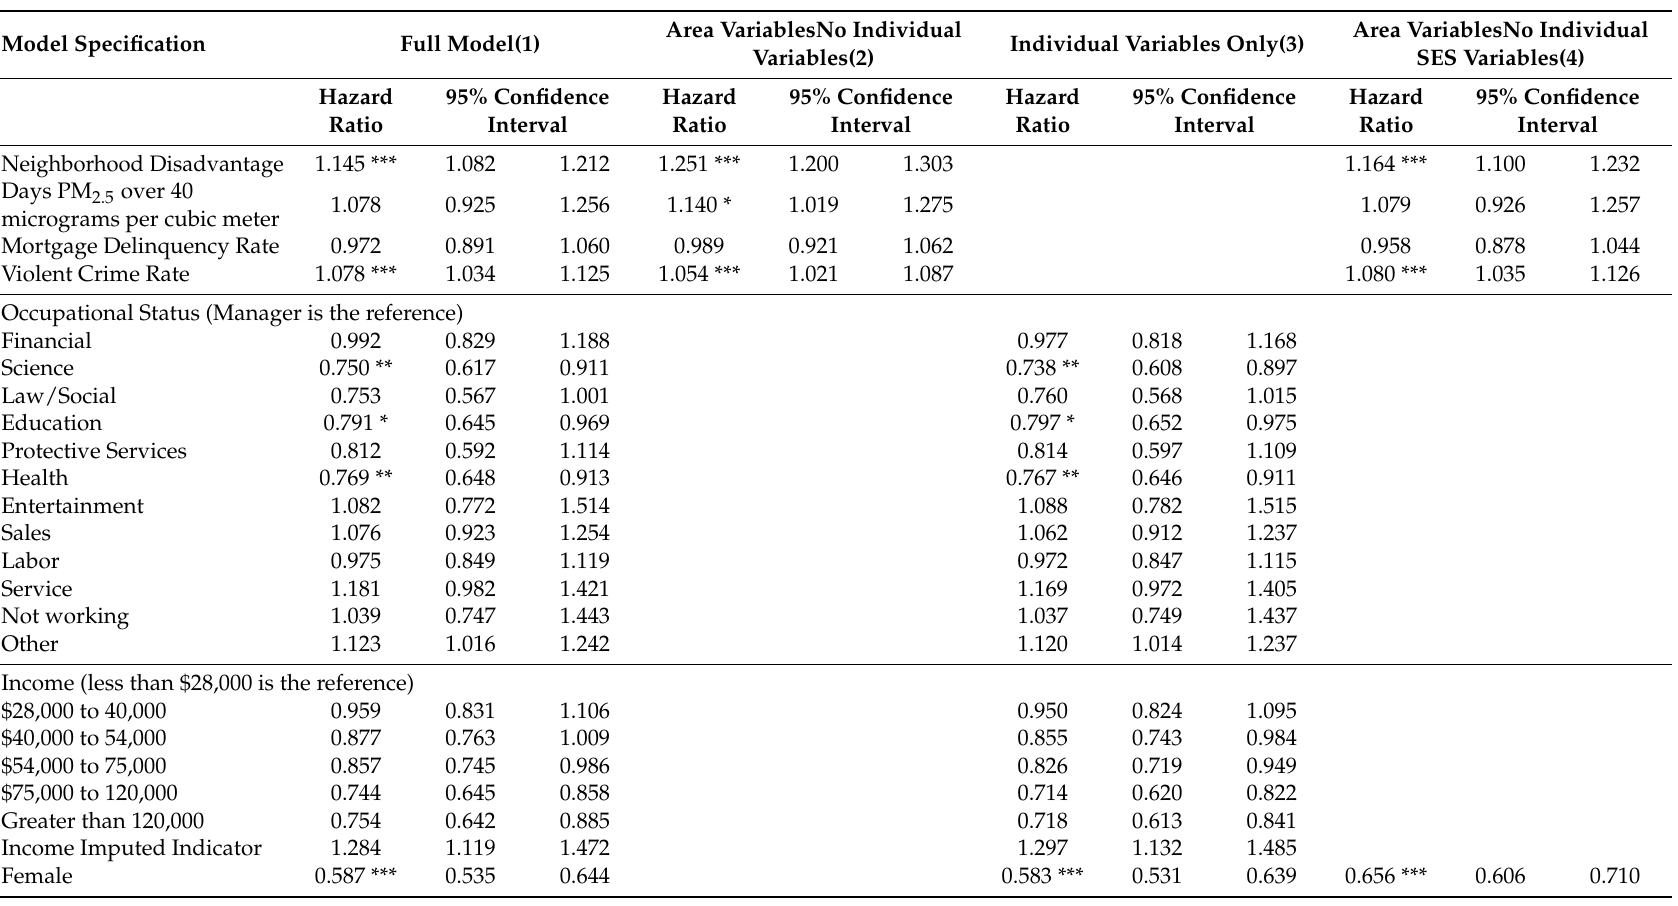
Table 6. Weighted estimated hazards of dying by area-level factors, individual occupational status, and personal income, all